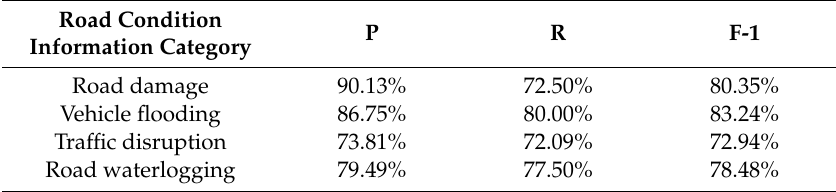
Table 2. Classification accuracy of di ff erent damage